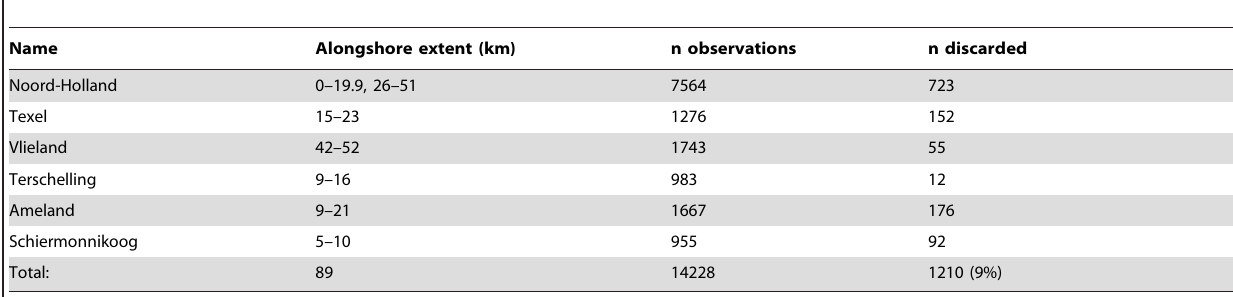
Table 1. Longshore extent of the six coastal sections, showing the total number of profile measurements available for the section and the number of profiles